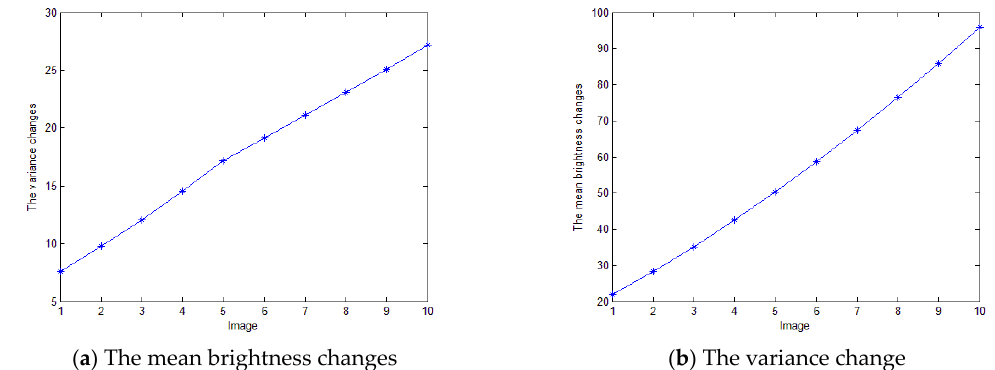
Figure 9. ( a , b ) The mean brightness and variance changes corresponding to different parameters during daytime imaging.